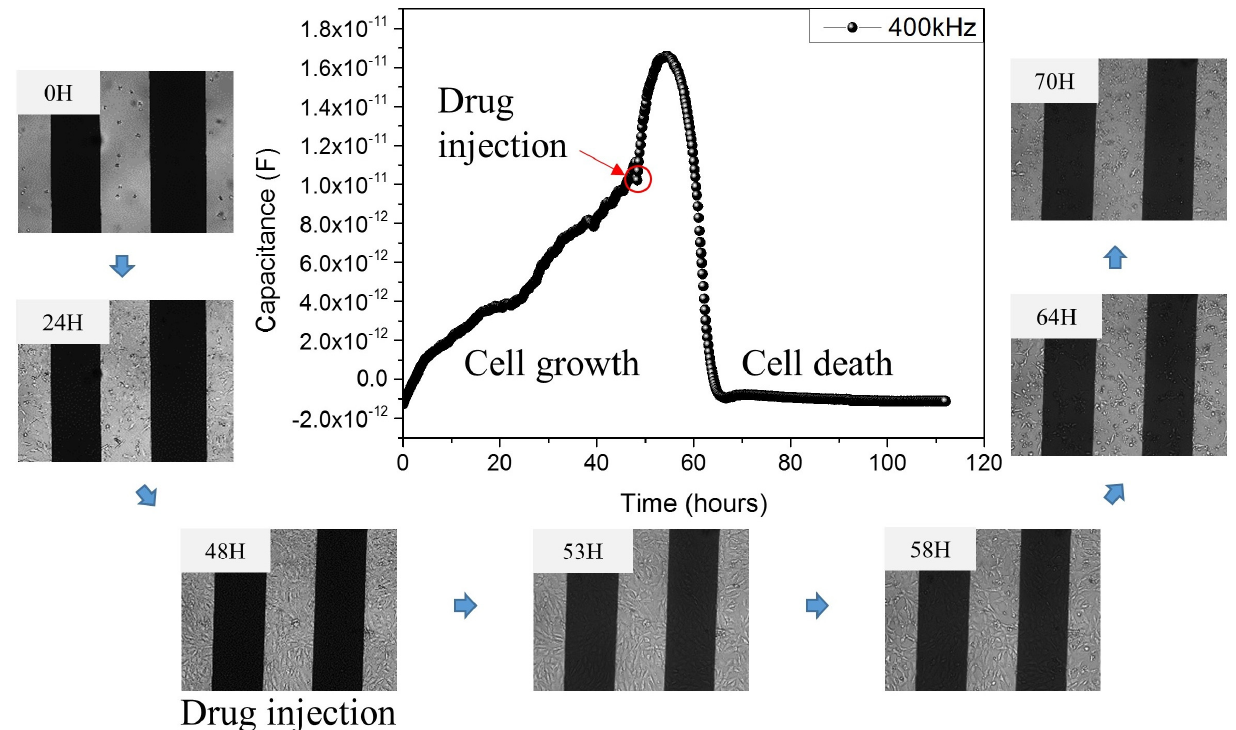
Figure 5. Comparison of microscope image and electrical signal on cell growth and death state.